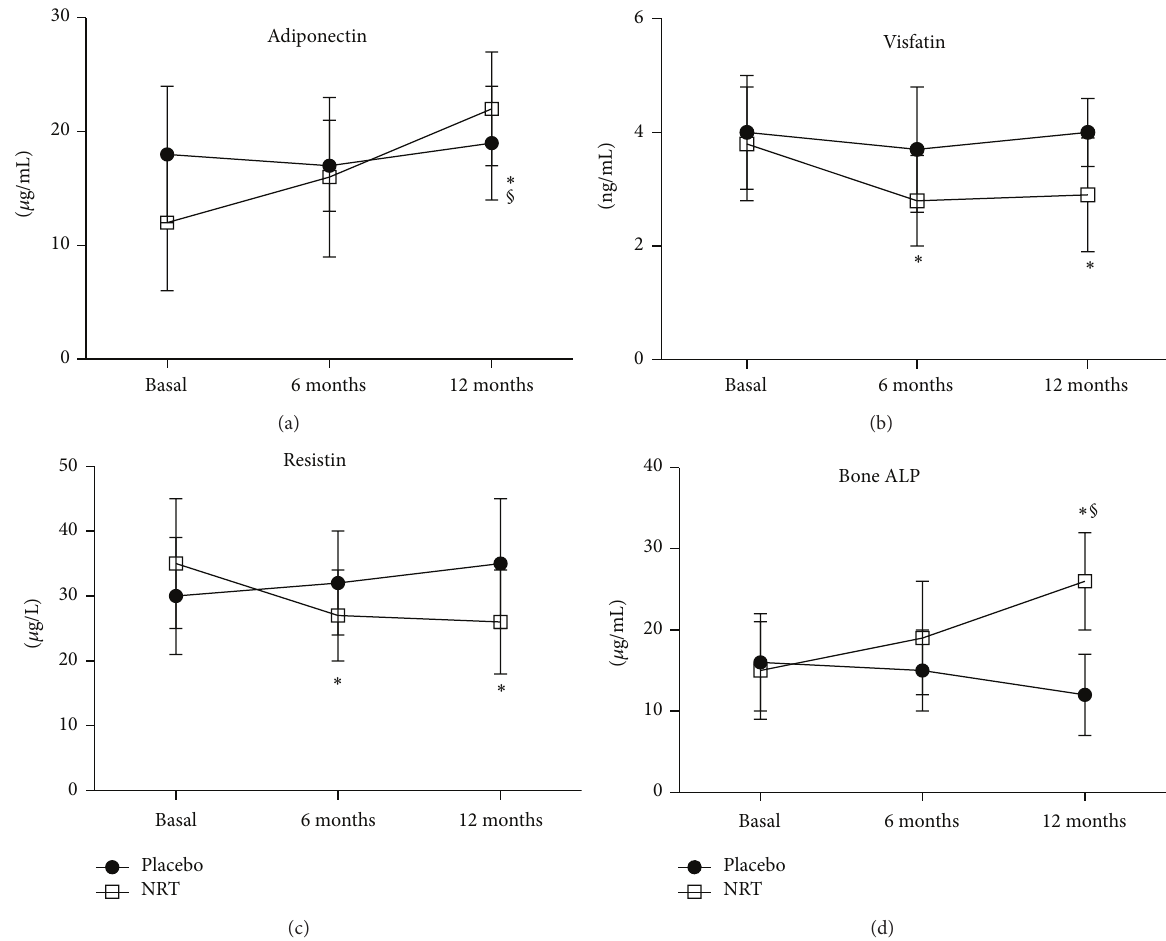
Figure 3: Adiponectin, visfatin, resistin, and bone-ALP blood levels through the study. ∗ 𝑃 < 0.05 versus basal; § 𝑃 < 0.05 versus placebo.